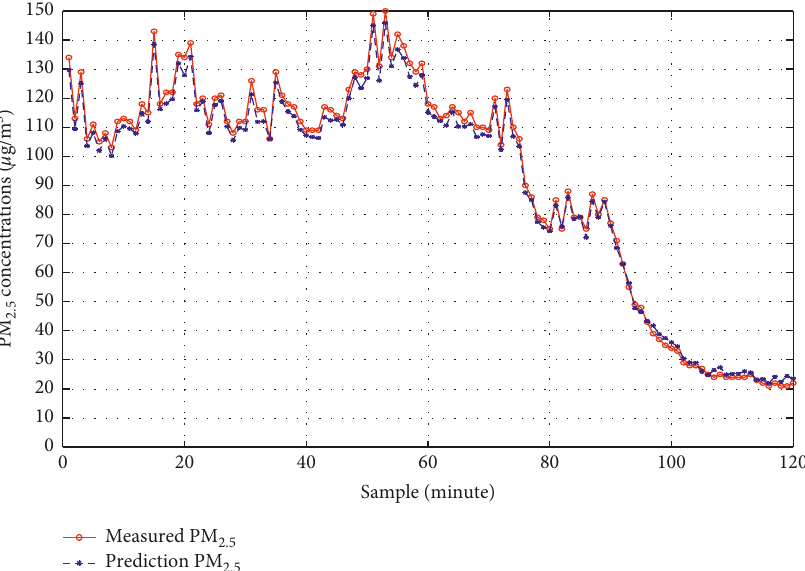
Figure 9: PM 2.5 concentration prediction result of model 5 (AR-Kalman).